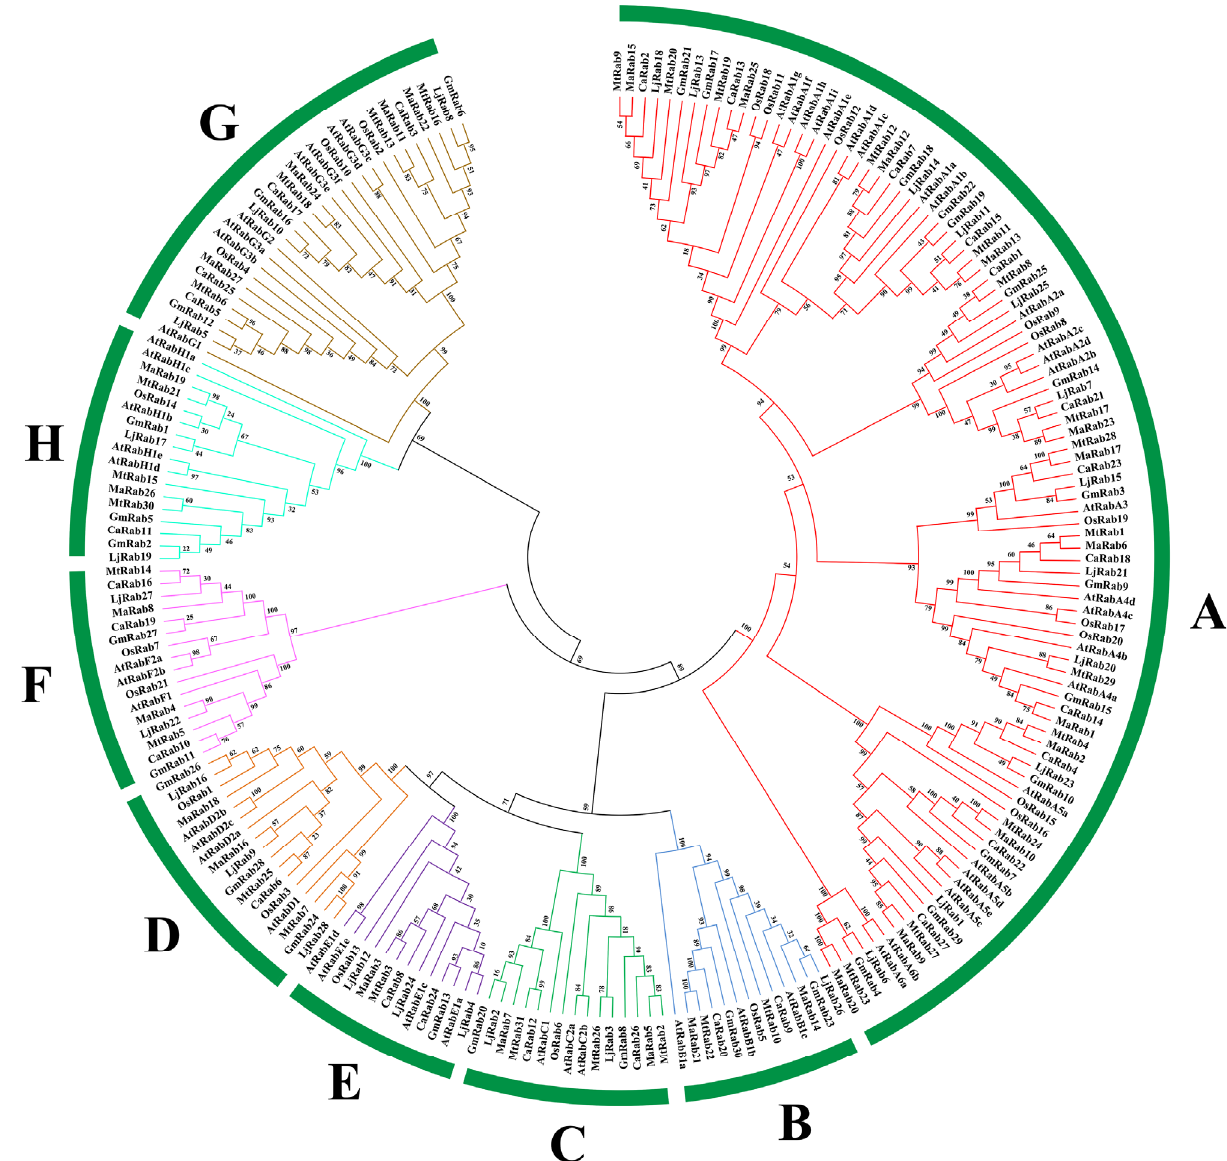
Figure 2. Phylogenetic analysis of Rab genes among M. albus , A. thaliana , M. truncatula , O. sativa , G. max , C. arietinum and L. corniculatus . The phylogenetic tree was constructed using the MEGA7 program with 1000 bootstrap replicates. The clusters of different colors in the figure represent different groups. These members were clustered into 8 groups (A–H). The number on the branch indicates the degree of reliability of this branch.